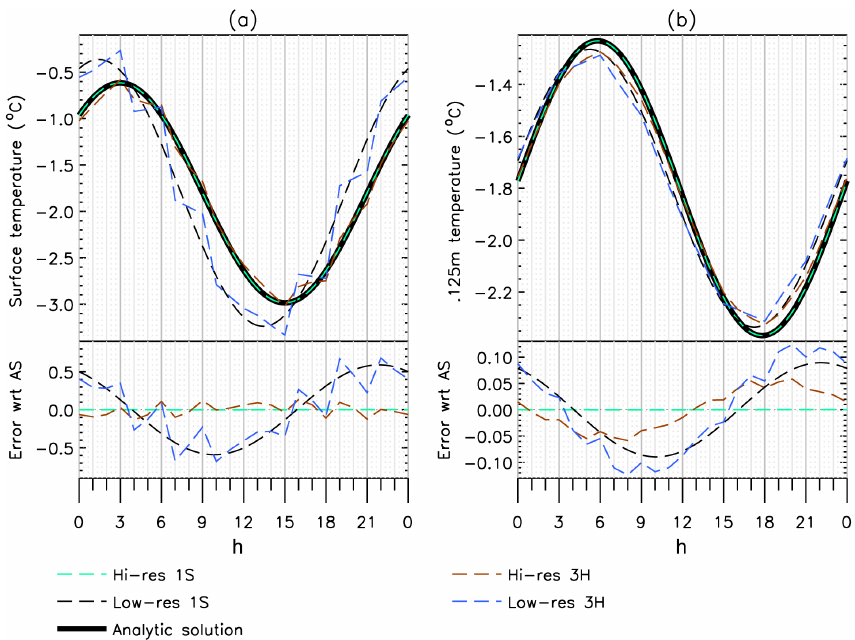
Figure 3. The performance of the CICE temperature solver under varying spatial resolution and time step length, with coupling period 3h. Showing (a) surface temperature; (b) temperature at 0.125m